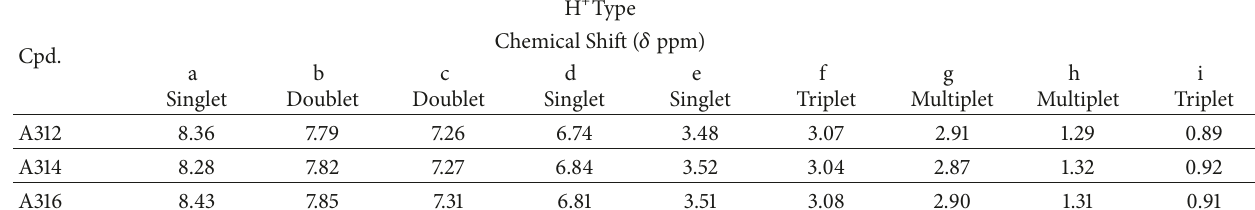
Table 2: 1 H-NMR spectroscopy of A312, A314 and A316.